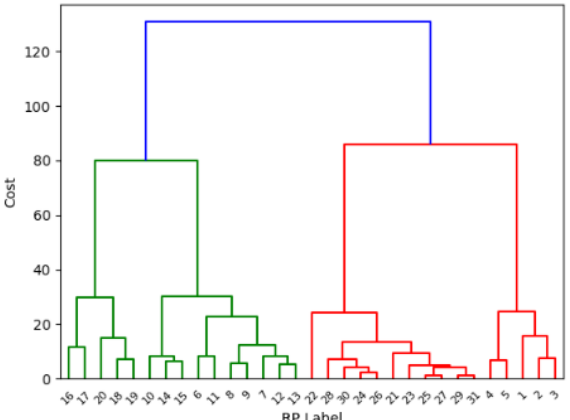
Figure 3. Hierarchical clustering process.